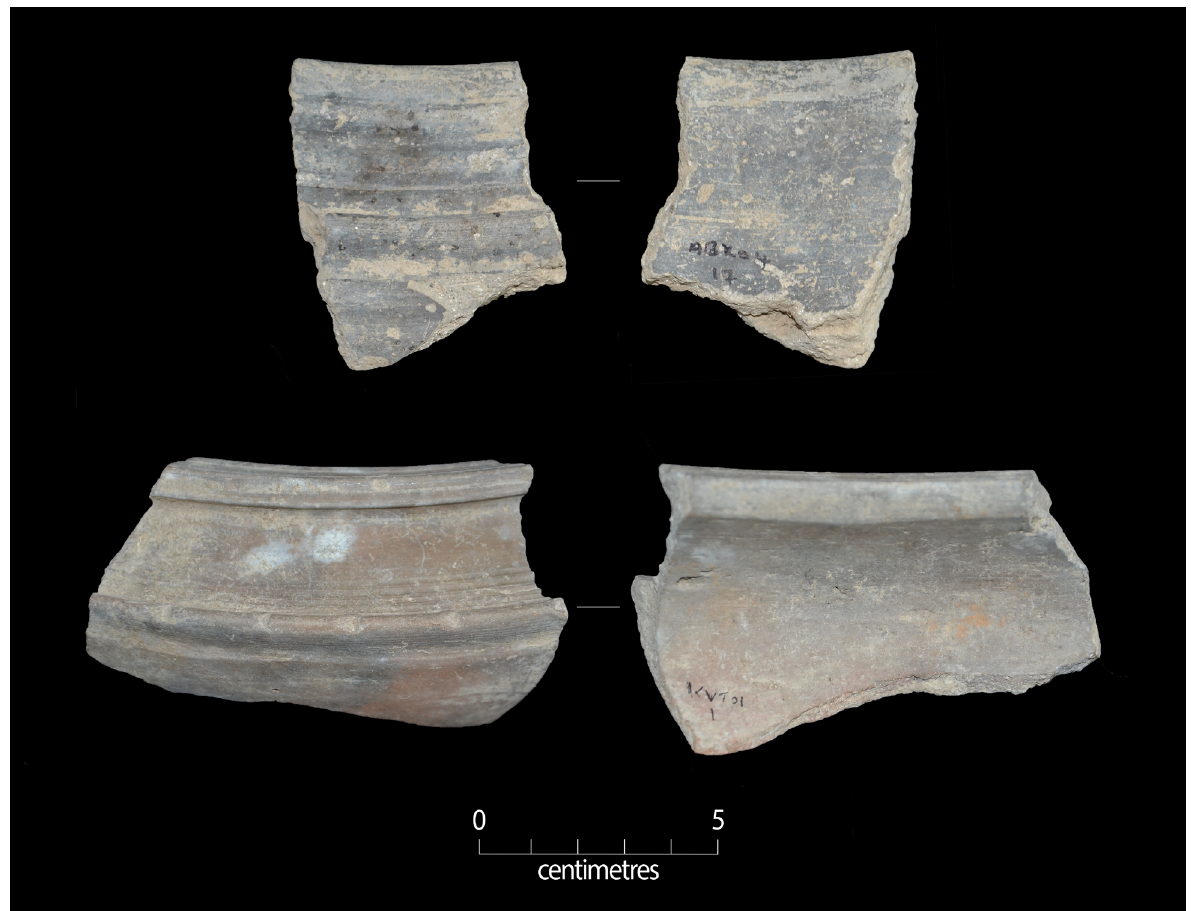
Figure 43: External and internal surfaces of Class 15 variant 2